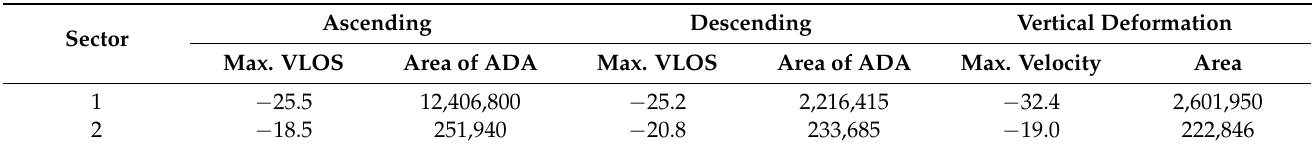
Table 6. Comparative analysis of main subsidence sectors, identified by ascending and descending ADAs and vertical deformation. Velocities are showed in mm year − 1 , with areas in m 2